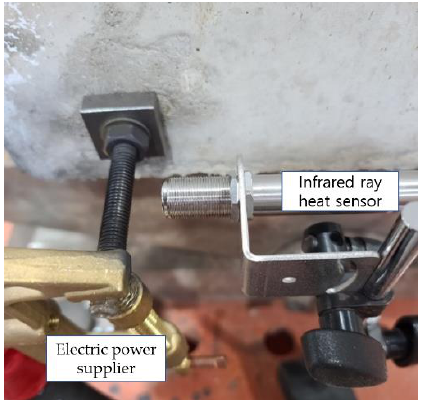
Figure 5. Overview of the activation system.